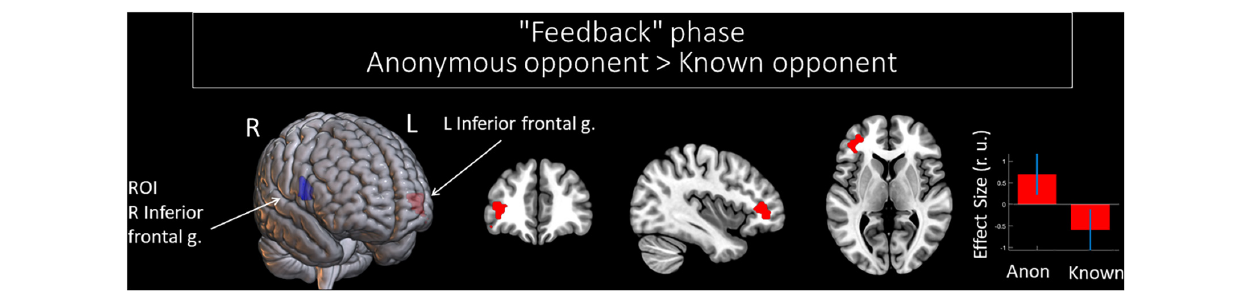
FIGURE 4 | Results of the group-level gPPI analysis with the ROI in the right IFG. Clusters of significant changes in functional connectivity, with the right IFG associated with the anonymity of the opponent (uncorrected p < 0.001 at the voxel level, FWE-corrected at the cluster level p < 0.05, and k = 15), are shown in red. The ROI in the right IFG is presented in blue. The plot shows effect sizes with 95% confidence intervals. L/R, left/right hemisphere; g., gyrus; ROI, the region of interest; Anon, anonymous opponent; Known, introduced opponent. TABLE 5 | Results of the group-level gPPI analysis with the ROI in the right IFG, associated with the observation of provocation from anonymous and known opponents (uncorrected p < 0.001 at the voxel level, FWE-corrected at the cluster level p < 0.05, and k = 15). Cluster Peak Peak MNI coordinates Brain